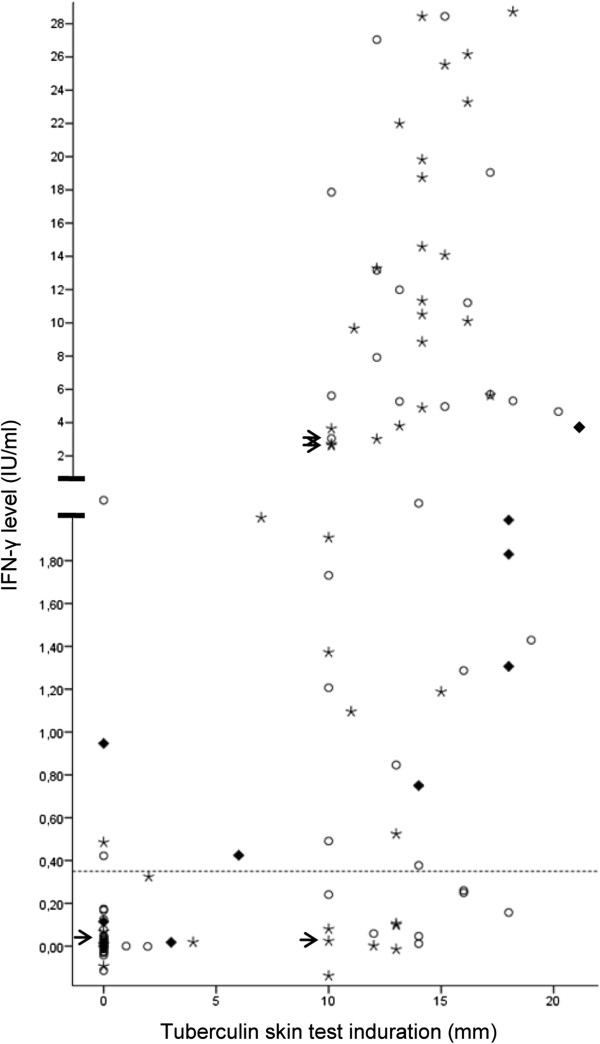
QuantiFERON®-TB Gold in-tube assay (QFT-GIT) and tuberculin skin test (TST) data upon inclusion from the 149 included children with both results and chest X-rays (CXRs) available. The QFT response is the level of IFN-γ (IU/ml) in the tuberculosis (TB) antigen-stimulated plasma sample with that for the negative control subtracted. Results for those 9 children who were diagnosed with TB at inclusion are represented by solid diamonds (in 2 children diagnosed with TB no QFT-GIT was performed). Results for those who showed TB sequelae at CXR are represented by asterisks. The arrows point to the results of 4/5 children (in 1 child no QFT-GIT was performed at inclusion) who progressed to active TB during follow-up. The dotted line represents the 0.35 IU/ml cutoff for the QFT-GIT test.